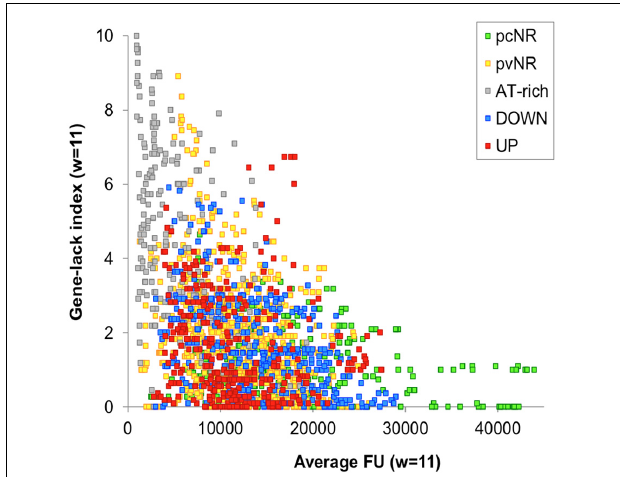
FIGURE 10 | Evidence for conservation of UP and DOWN domains in S. pneumoniae . Relationship between the gene-lack index and gene expression (fluorescent units, FU) in S. pneumoniae R6 as detected in high density microarrays. A total of 12 genome sequences (from 11 clinical isolates and R6) were analyzed. Genes of clinical isolates were considered equivalent to those of R6 when their products shared ≥ 80% similarity over ≥ 80% of the sequence length. An 11-gene window (about 10 kb) was